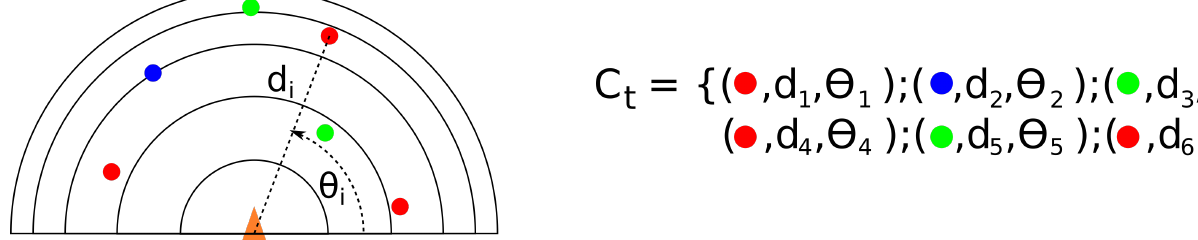
Figure 4. The context in the agent’s egocentric reference frame: the orange triangle is the agent, colored dots are visual cues. The elements in the current context are given in polar